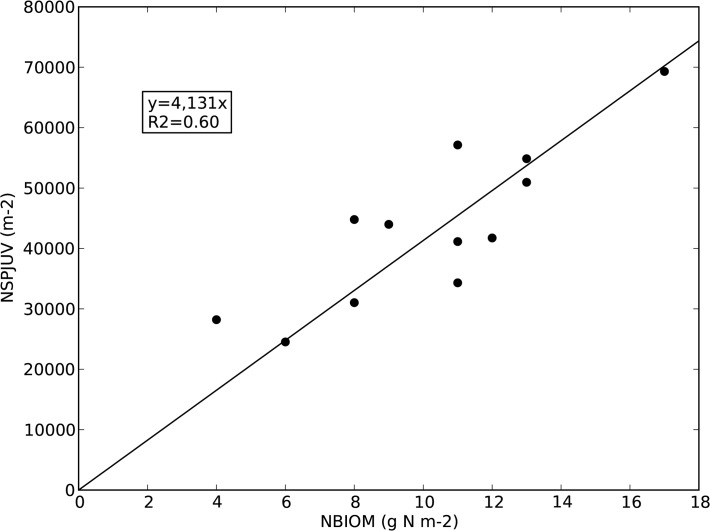
Relation between number of juvenile spikelets as a function of total nitrogen in above ground biomass, variety IR72, based on data presented in Yoshida et al. [27].